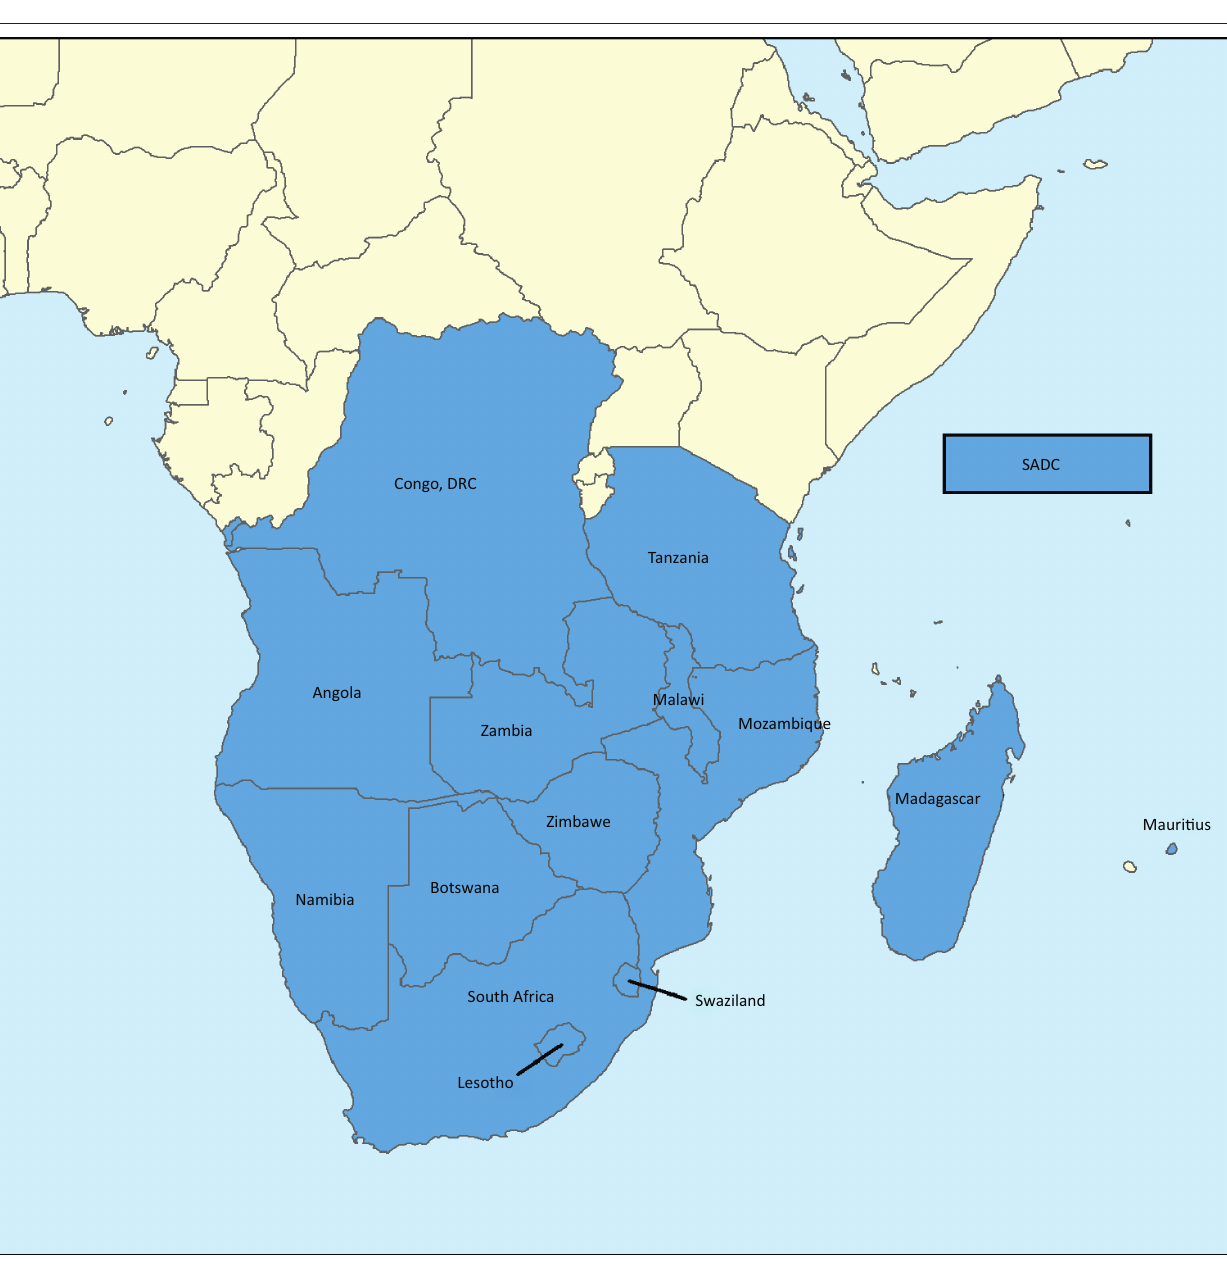
FIGURE 1: Map of Southern African Development Community member